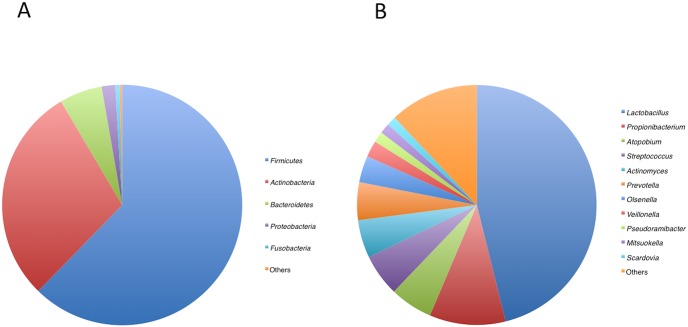
Mean bacterial distributions of bacterial phyla (A) and genera (B) in carious dentin.